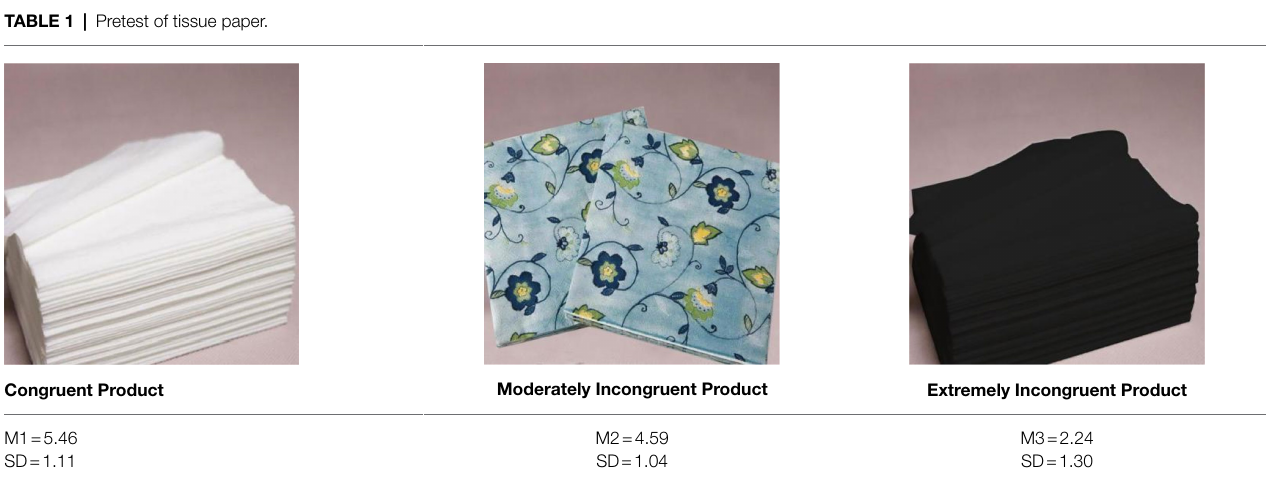
TABLE 1 | Pretest of tissue